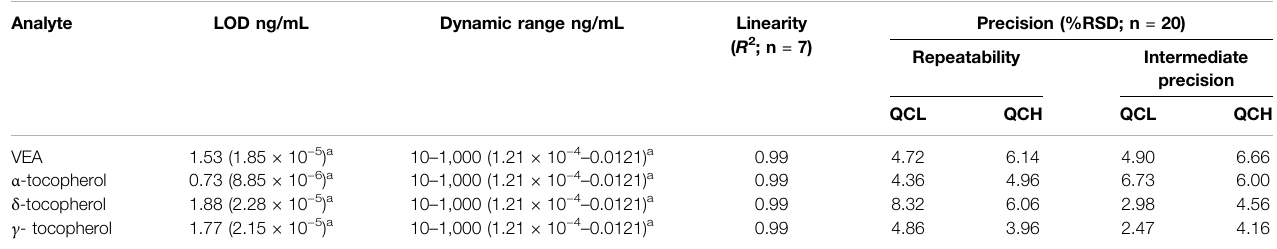
TABLE 3 | Method precision, range, and linearity for VEA and other tocopherols. Analyte